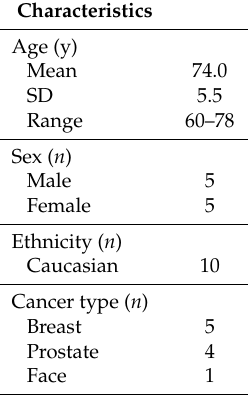
Table 1. Summary of participant characteristics.